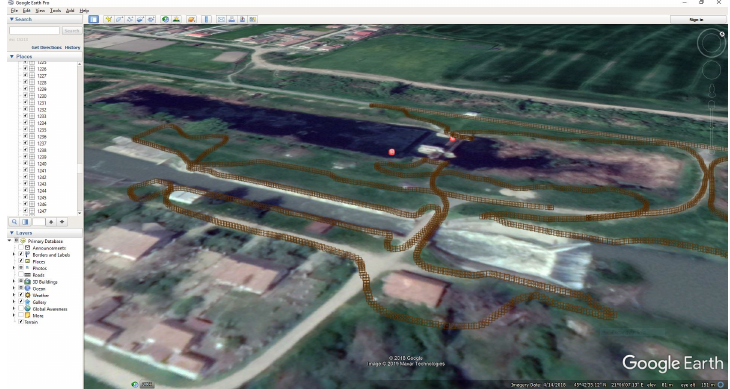
Figure 12. Image orientation and export of KML file for Sânmihaiu Roman Lock.